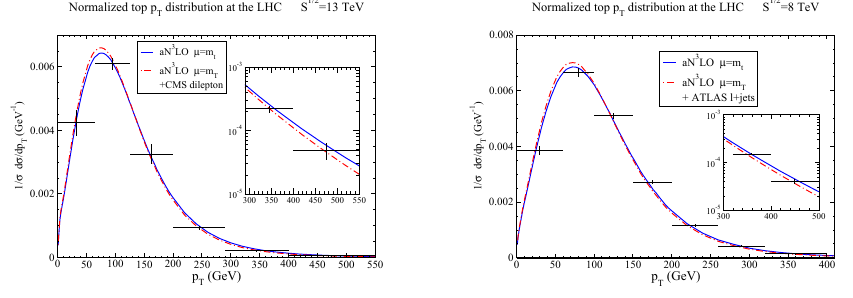
Figure 5. aN 3 LO top-quark normalized p T distributions (left) at 13 TeV energy compared with CMS [50] data and (right) at 8 TeV energy compared with ATLAS [51] data.